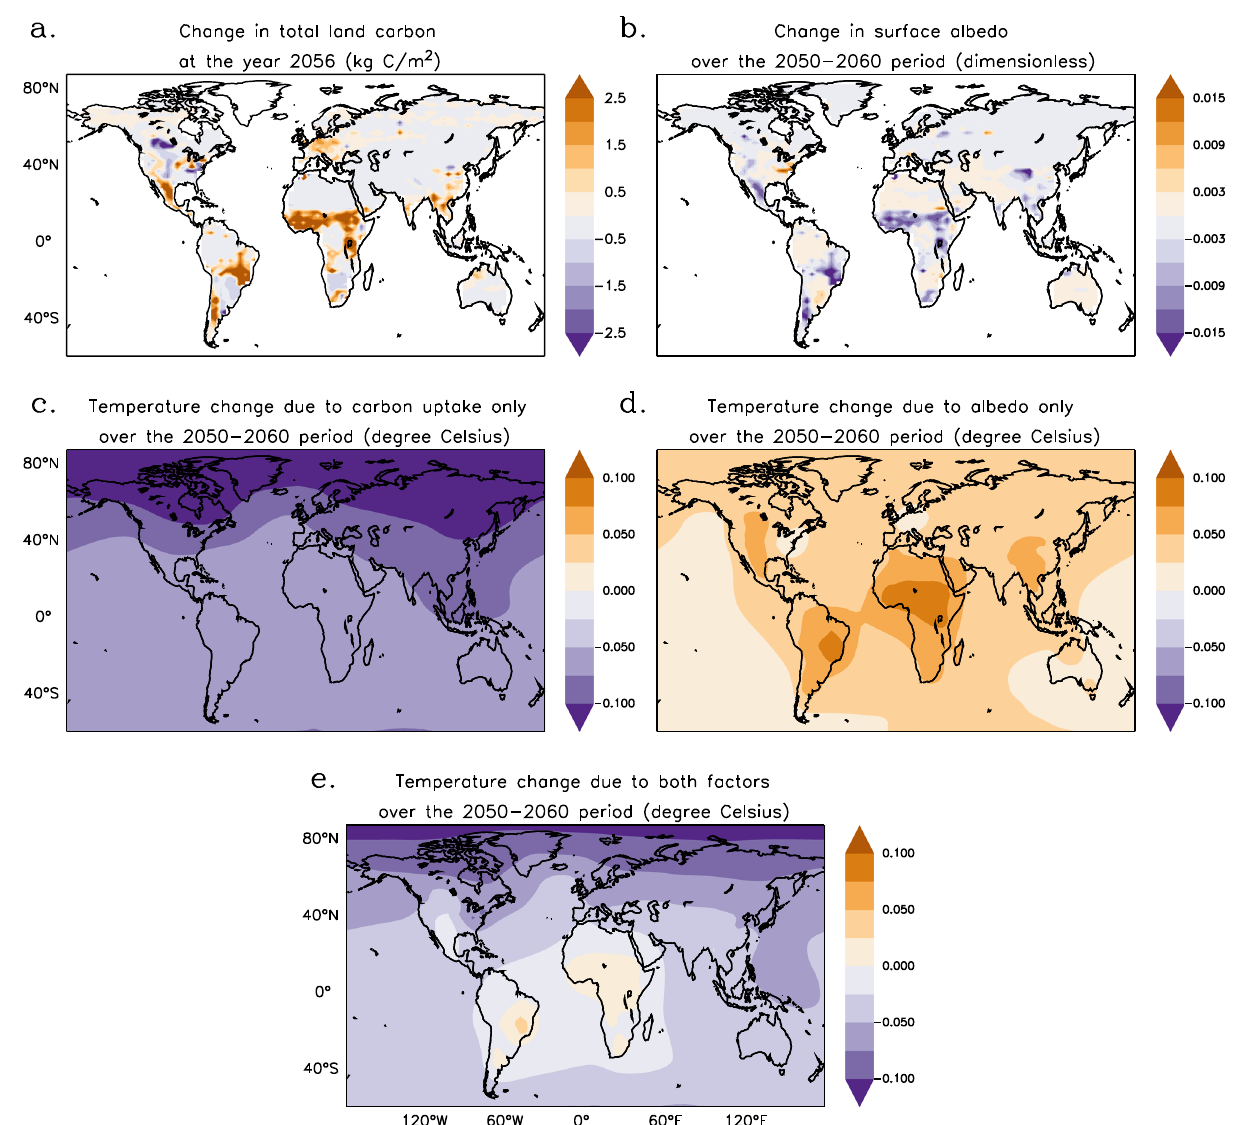
Fig. 3 Spatial pattern of climate response to carbon sequestration and surface albedo changes resulting from temporary reforestation scenarios. a Our scenario of reversed historical deforestation led to a global land carbon increase of 129 GtCO 2 , which occurred primarily in tropical and subtropical regions. b The primary biophysical effect of expanded forest cover was to decrease land surface albedo in areas of signi fi cant reforestation. d These surface albedo decreases led to a spatial pattern of warming that was concentrated in areas of larger forest cover increase, whereas c the cooling due to carbon sequestration was larger at higher latitudes owing to regionally stronger climate feedbacks. e Consequently, the pattern of the net climate response to reforestation showed cooling over most of the land areas, but a small net warming over some tropical continental